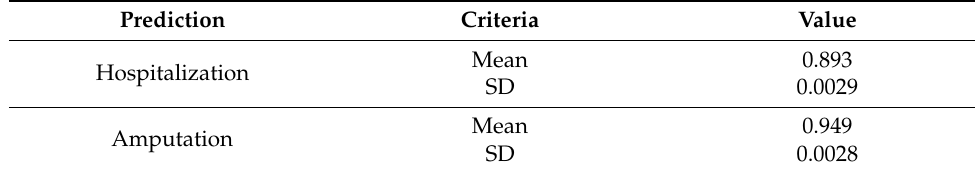
Table 6. Cross-validation